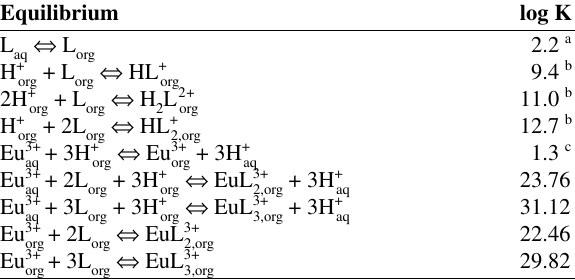
Table 5. Equilibrium constants in the water–HNO mounts)–nitrobenzene– N,N,N’,N’ -tetrabutyl-1,10-phenanthroline- 2,9-dicarboxamide (L) – H + B – system.